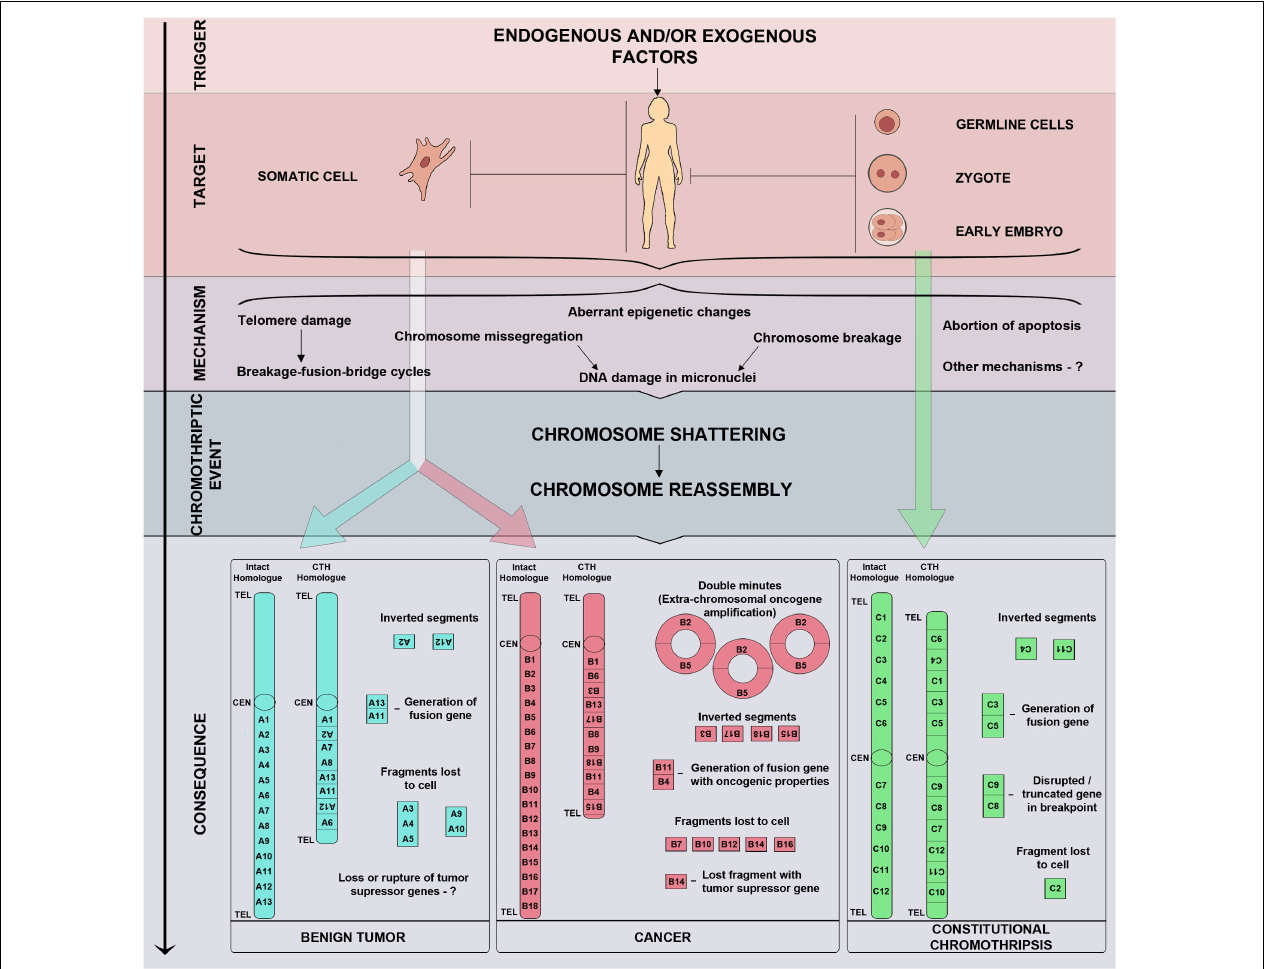
FIGURE 1 | Triggers, mechanisms, and consequences of chromothripsis. Chromothripsis may arise in any cell, including somatic cells, germline cells, zygotes, and blastomeres of preimplantation embryos, thus, determining the fate of an affected organ or the whole organism. Chromothripsis is induced by exogenous and/or endogenous factors which trigger chromosome shattering and sequential reassembly of fragments through micronuclei formation, breakage-fusion-bridge cycles, aberrant epigenetic regulation, abortive apoptosis, and other yet unknown